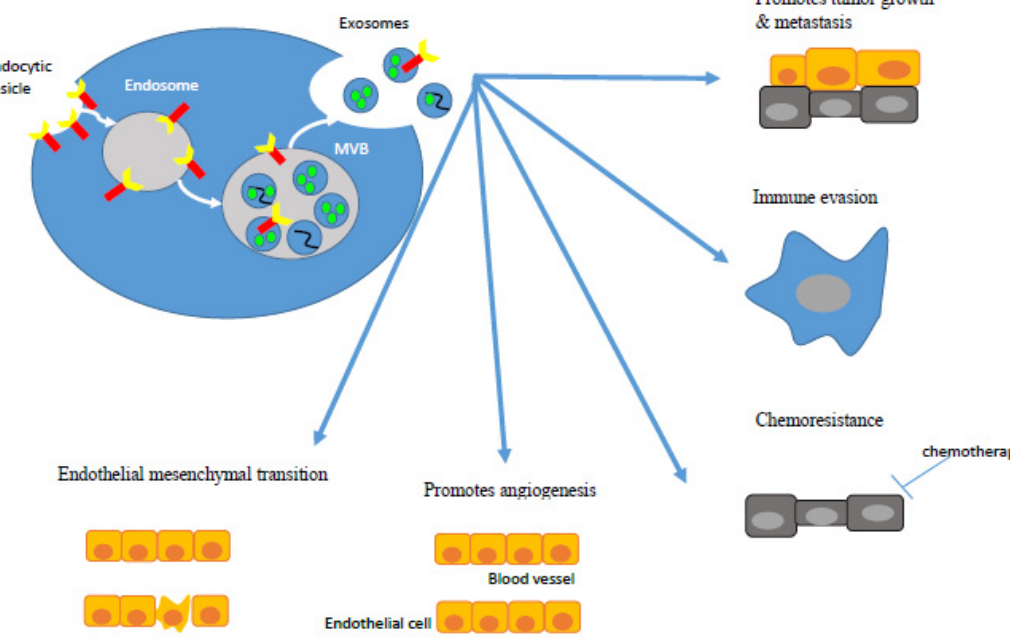
Figure 1. Exosome biogenesis and role in colorectal cancer